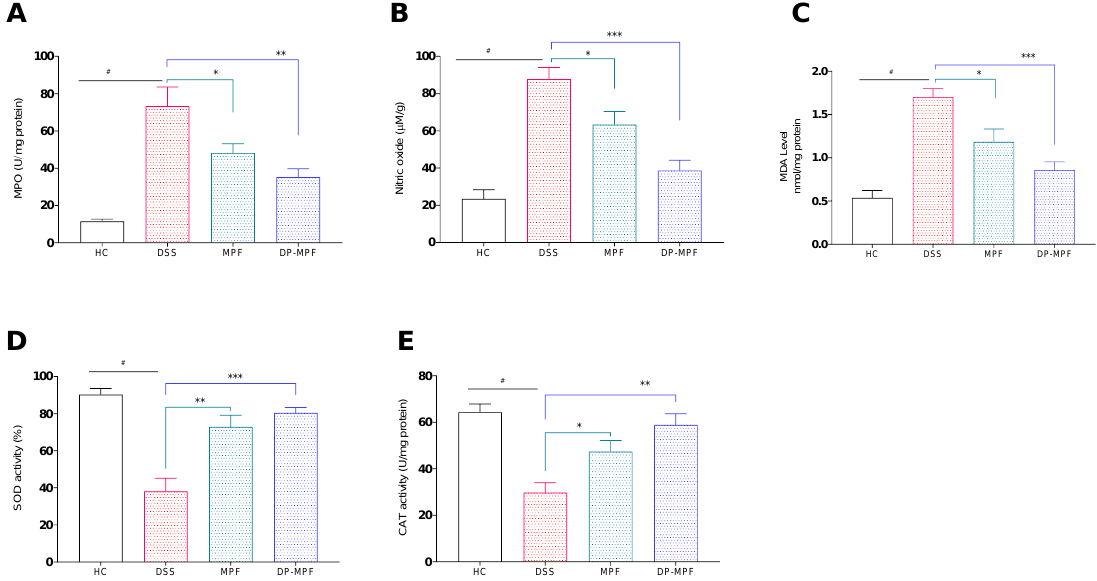
Figure 4. Effect of MPF and DP-MPF on oxidative stress markers and antioxidant enzymes in DSS- induced acute colitis. ( A ) Myeloperoxidase (MPO) activity in DC, ( B ) nitric oxide (NO) concentration ( µ M)/gram in DC, ( C ) Malondialdehyde (MDA) levels in the DC, ( D ) total SOD activity in the DC representing the reduction of xanthine oxidase activity, expressed as a % inhibition and ( E ) CAT activity in DC. Data expressed as a mean ± SEM ( n = 5/group). Statistical significance was evaluated using one-way ANOVA followed by Tukey’s post-test, A p -value of <0.05 was considered significant, * p < 0.05, ** p < 0.01 and *** p < 0.001. # Significant effect HC vs. DSS ( p < 0.05); * Significant effect treatment vs. DSS (DSS vs. MPF) or (DSS vs. DP-MPF).